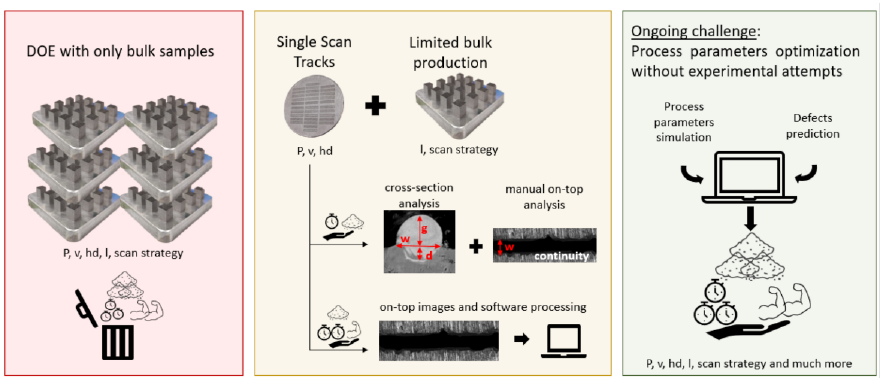
Figure 5. Different process parameter optimisation